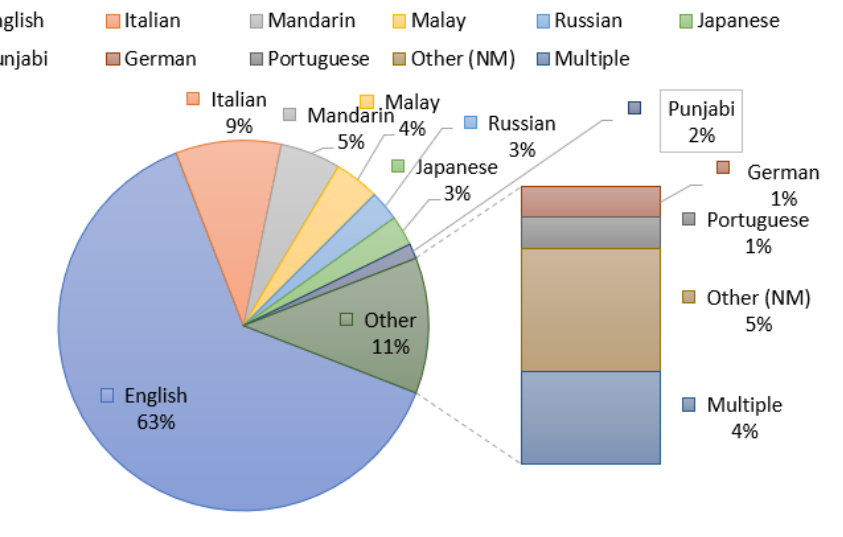
Figure 8. Languages used in the studies.